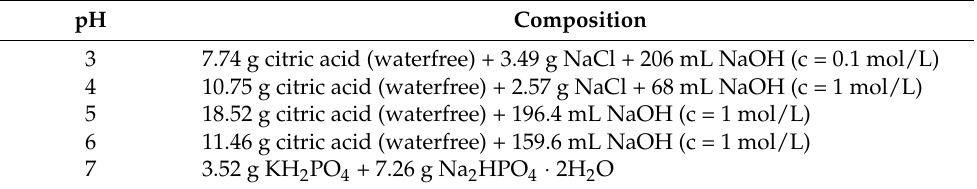
Table 2. Composition of the buffer solutions used to adjust the pH of the media